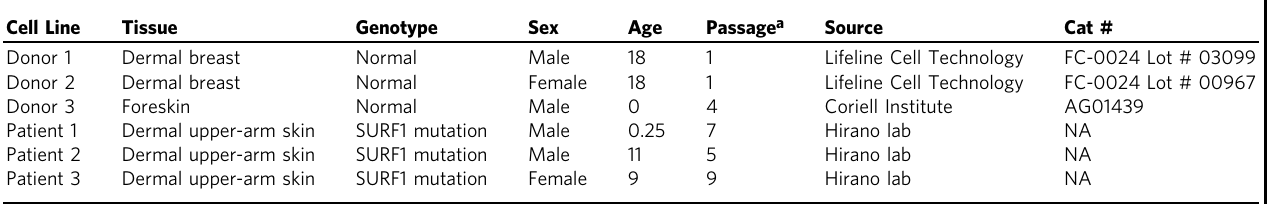
Table 2 Control and SURF1 donor characteristics.